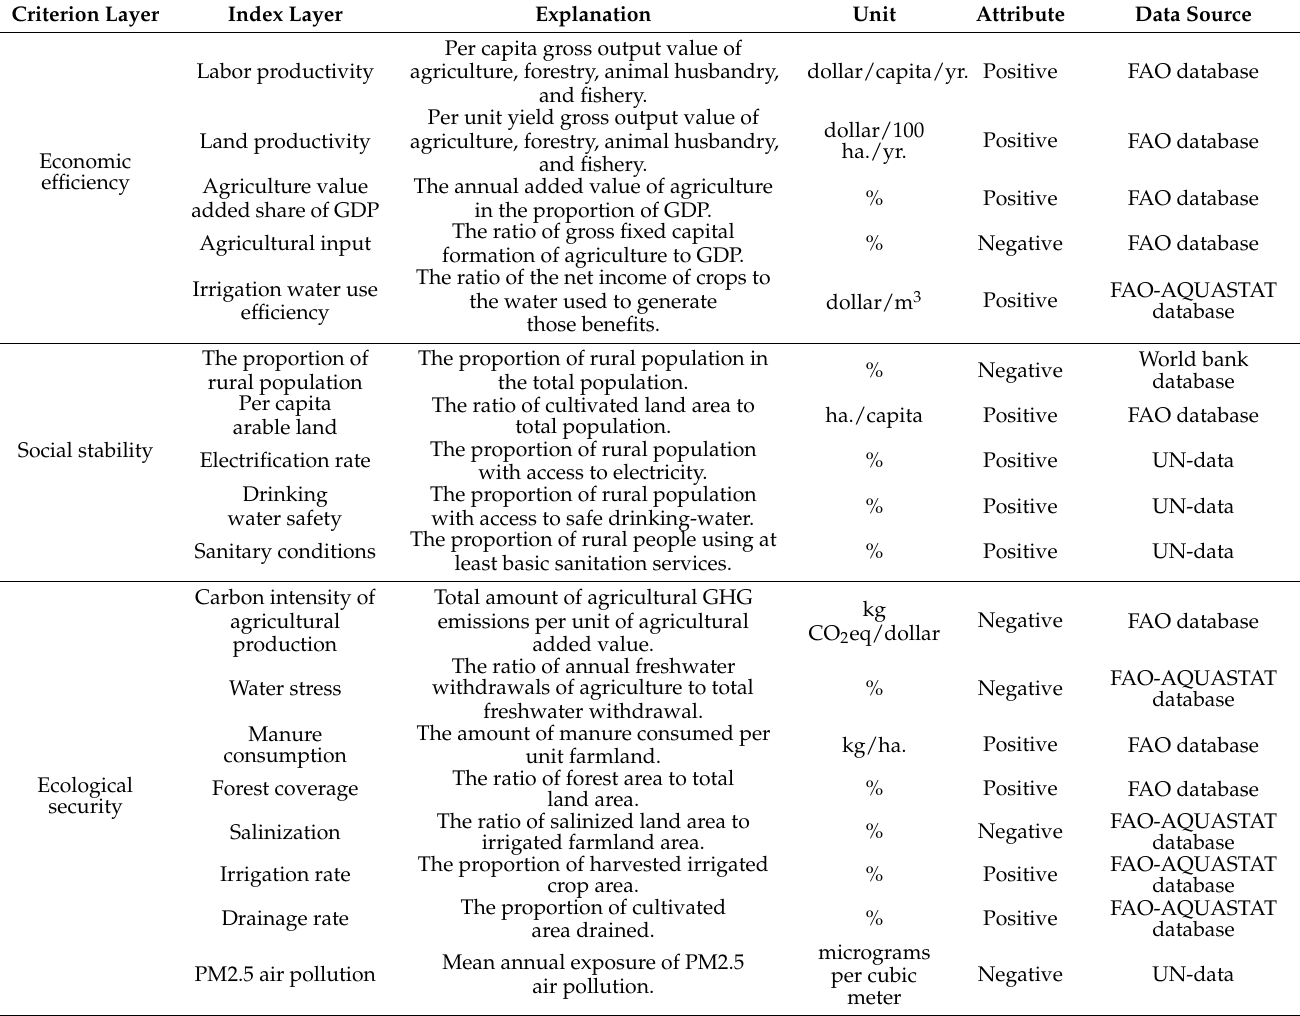
Table 1. Evaluation indicator of agricultural sustainability.